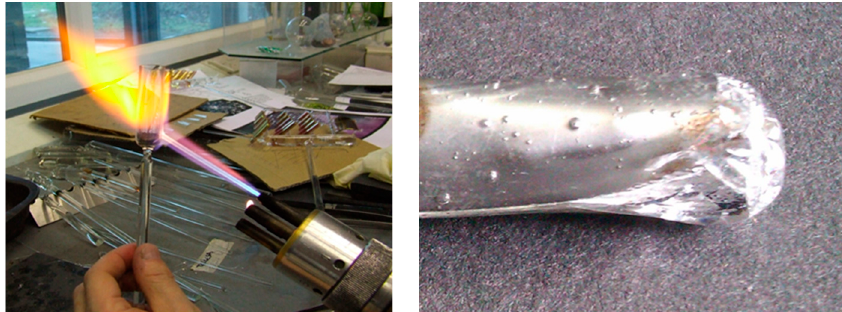
Figure 6. Gallium inclusion applied in borosilicate glass by lampworking; created by author.